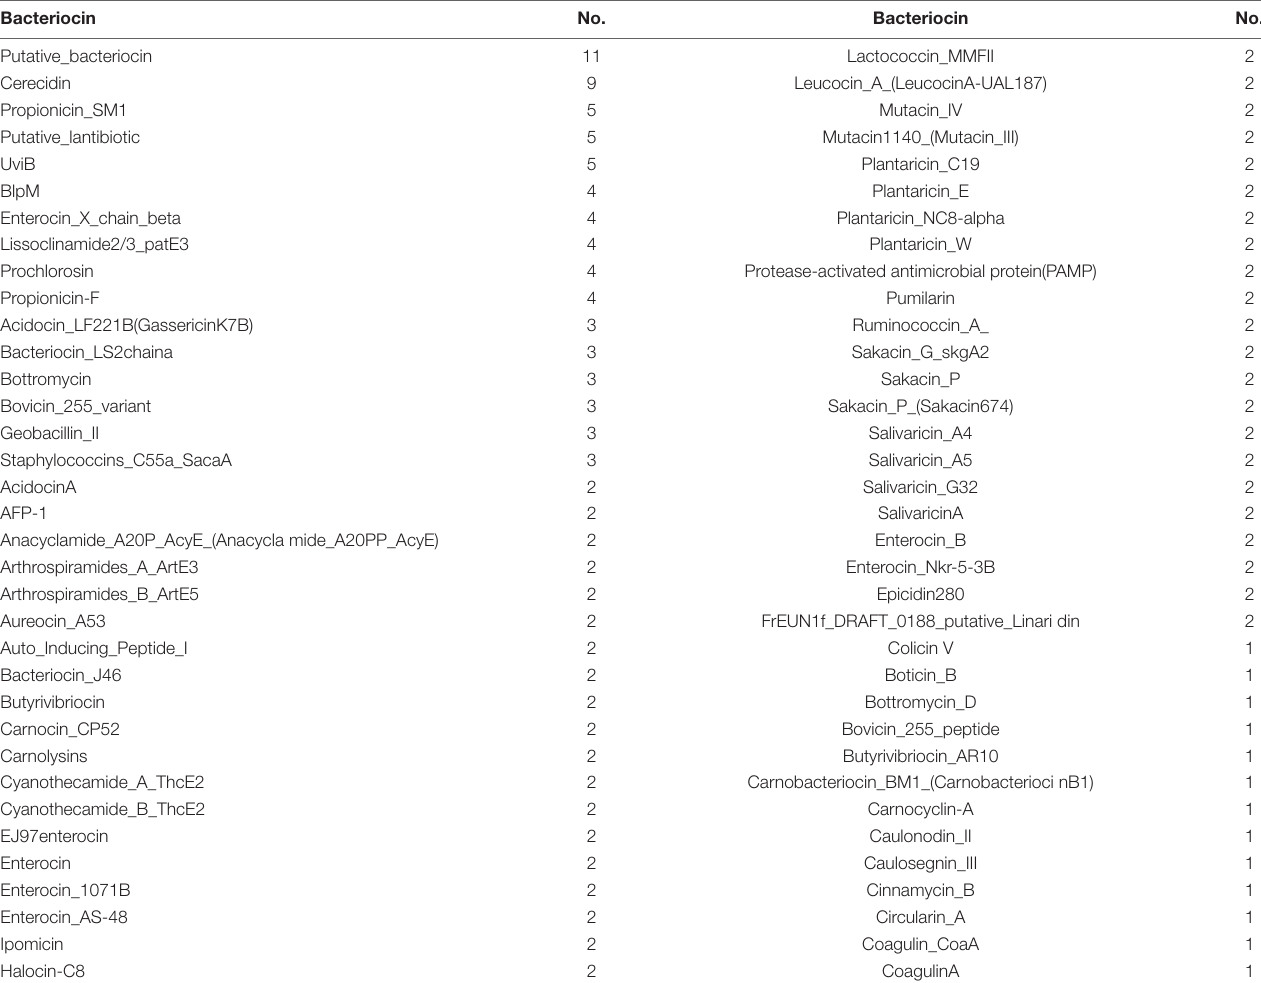
TABLE 2 | List of some bacteriocin identified in the PHM 11 genome. Bacteriocin No.